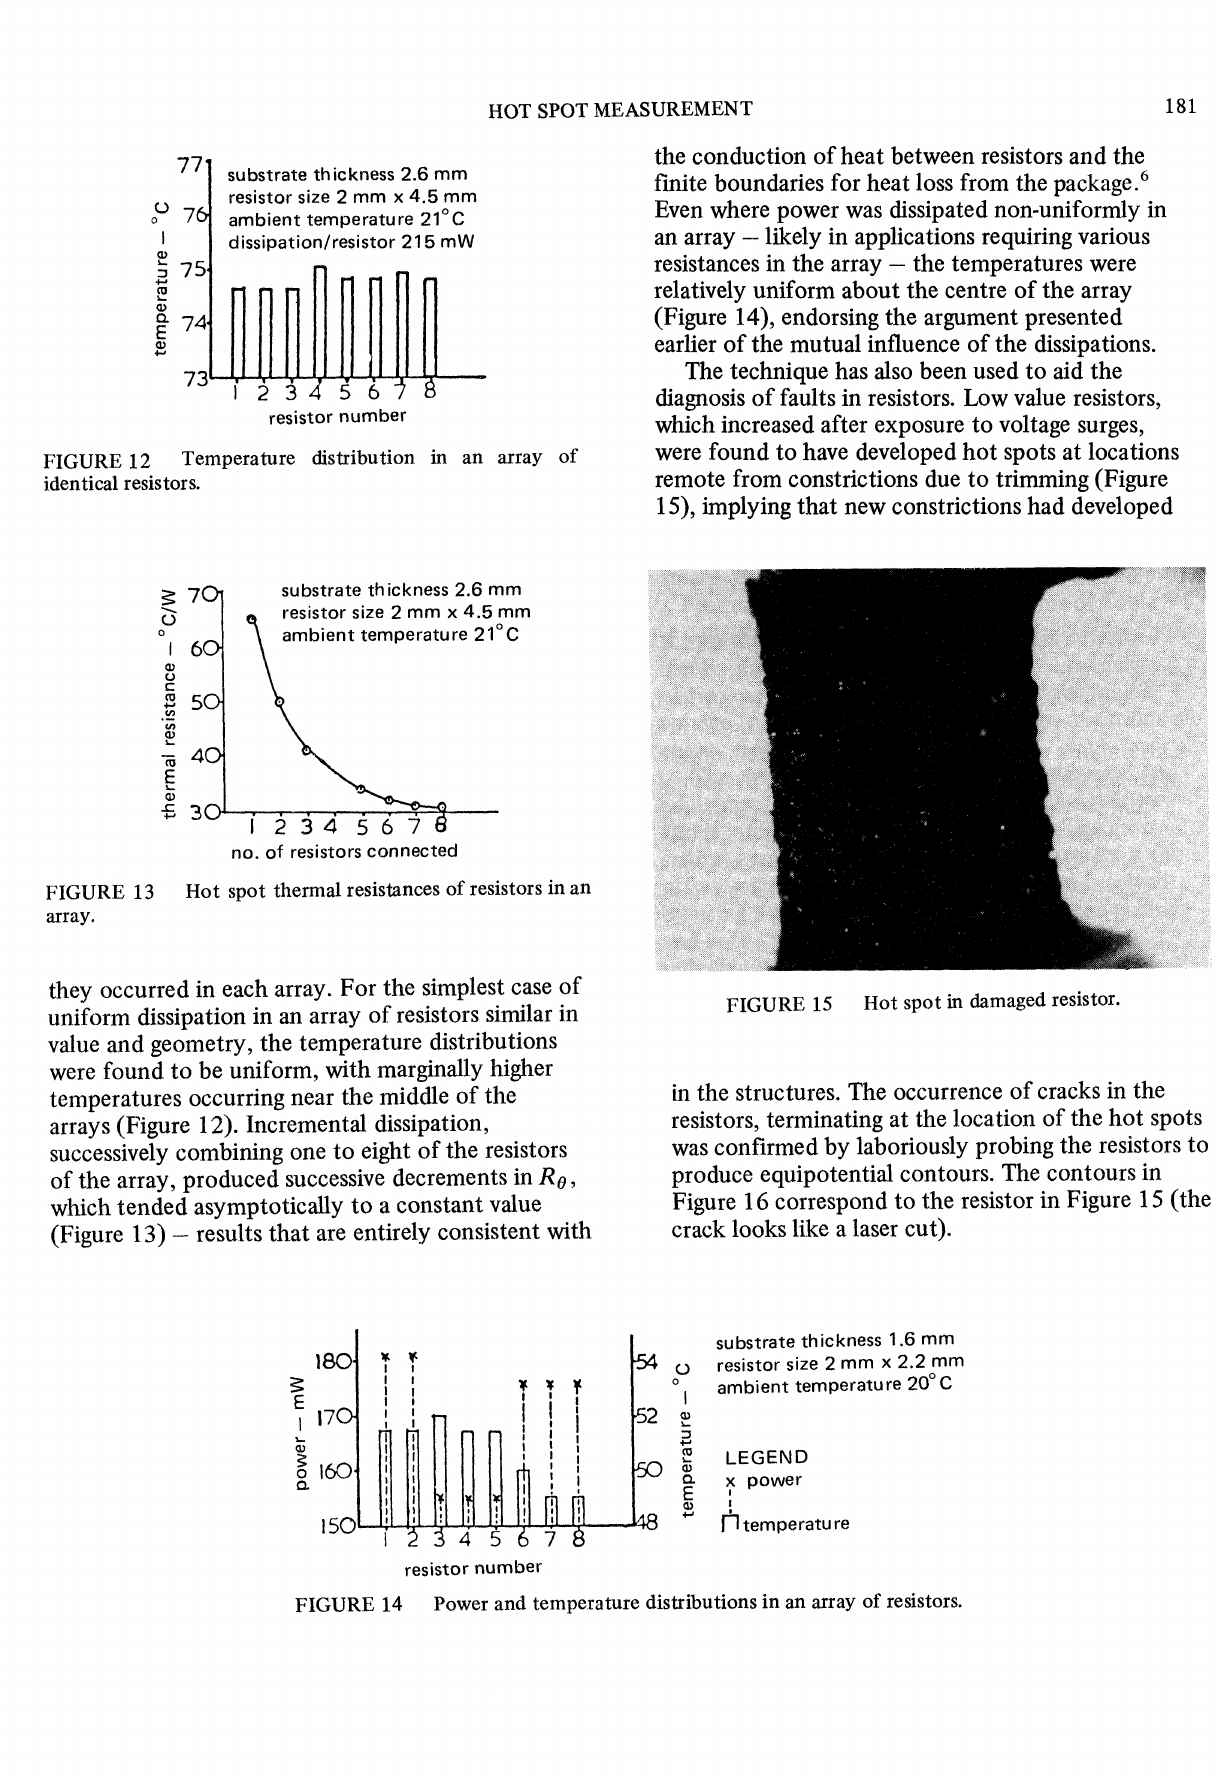
FIGURE 1.4 Power and temperature distributions in an array of